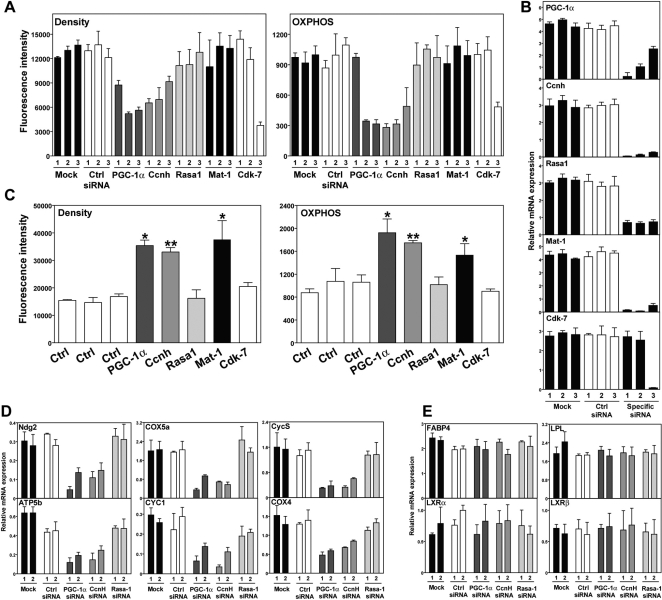
Validation of cyclin H as a regulator of oxidative phosphorylation.(A) Three individual siRNAs against two candidate genes (CCNH and RASA1) were transfected into HIB1B preadipocytes. siRNAs against PGC-1α and functional partners of CCNH were used for comparison. Mitochondrial density and oxidative phosphorylation (OXPHOS) were evaluated by FACS (see Methods). (B) RNA isolated from cells treated as in (A) was used to verify knock-down of gene expression using qRT-PCR. (C) Overexpression of CCNH, but not RASA1, resulted in increased mitochondrial activity. HIB1B cells were transfected with expression vectors for the indicated genes, and mitochondrial parameters were measured 72 hr later. (D) To confirm the effect on oxidative phosphorylation measured using Mitotracker dyes, expression of six known OXPHOS genes was assayed using qRT-PCR in response to siRNAs targeting PGC-1α, CCNH, and RASA1. In all cases, knock down of CCNH, but not RASA1, resulted in decreased expression. (E) To confirm that the effect of CCNH was not due to general effects on transcription or cell viability, the expression of four control genes unrelated to OXPHOS was also measured by qRT-PCR. In all cases, siRNAs targeting CCNH produced no significant change in expression.